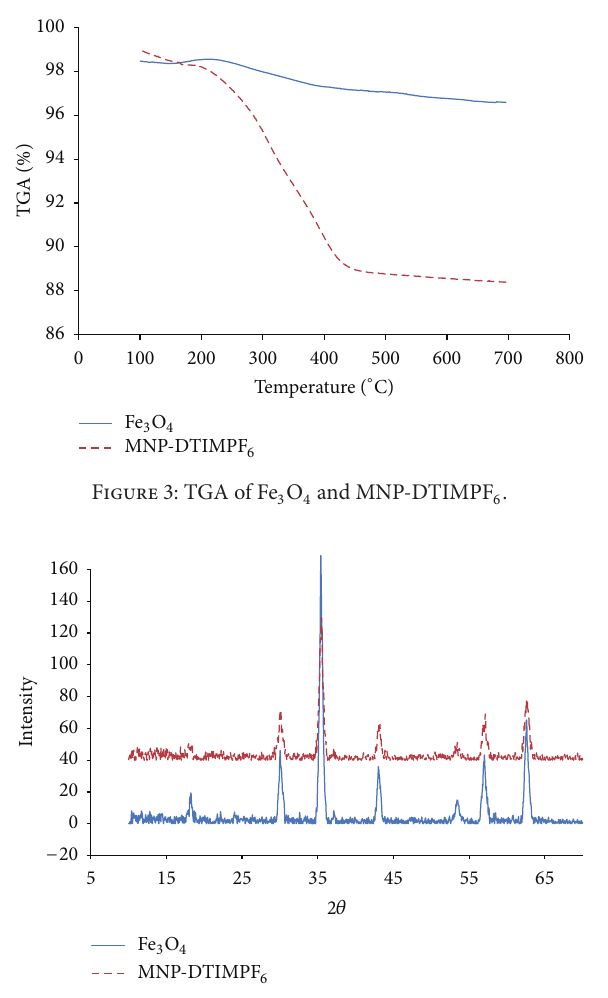
Figure 4: X-ray diffraction patterns of Fe 3 O 4 and MNP-DTIMPF 6 (Miller indices of the peaks are indicated).